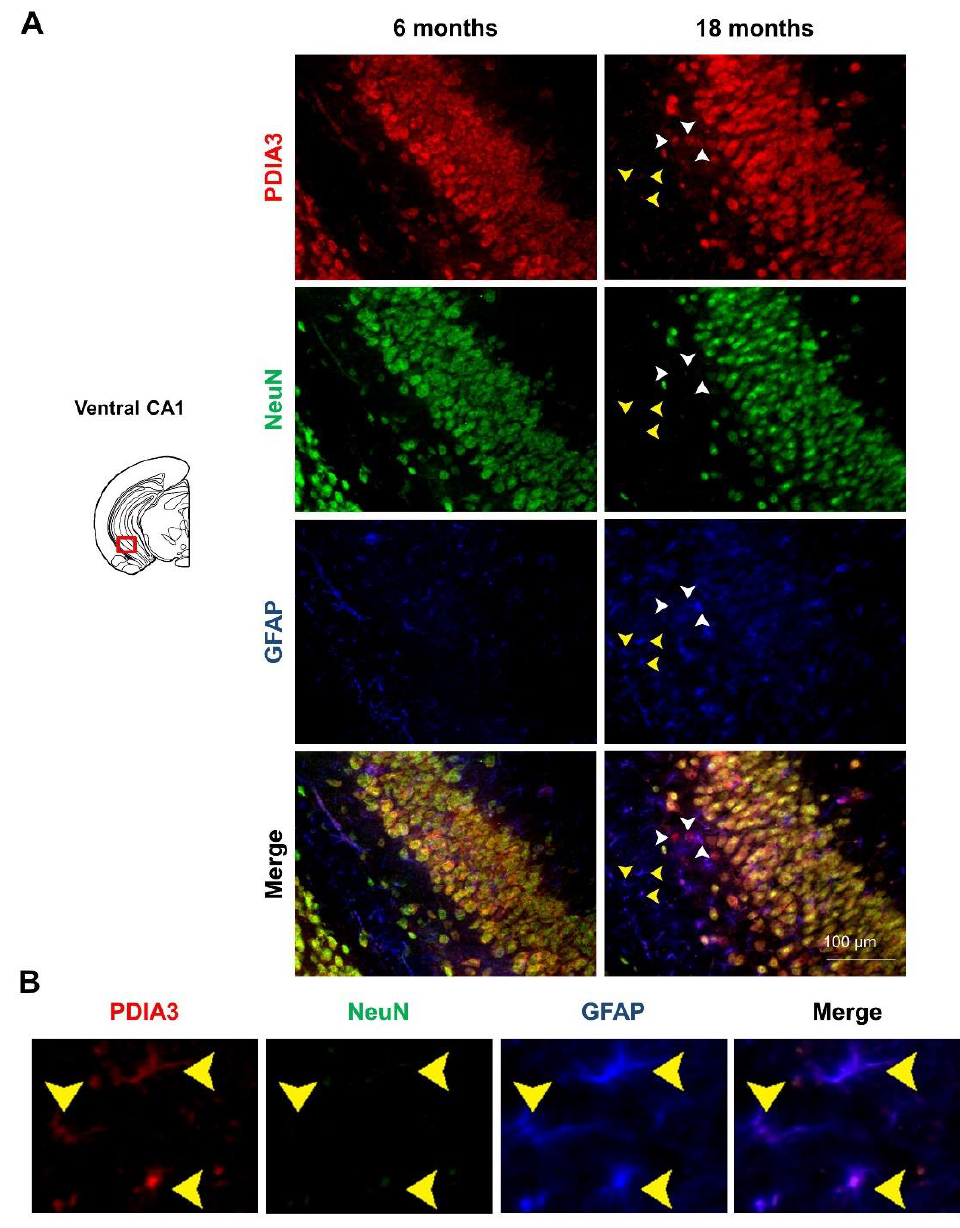
Figure 9. PDIA3-NeuN-GFAP protein levels observed in the ventral CA1 region of the hippocampus of 3 × Tg-AD mice: ( A ) Representative microphotographs of PDIA3-NeuN-GFAP triple-fluorescent immunostaining (red, green, and blue, respectively) performed on brain slices of ventral CA1 region of hippocampus collected from 6- and 18-month-old 3 × Tg-AD mice. The white arrows indicate the PDIA3 single-positive cells while the yellow arrows indicate the PDIA3-GFAP co-localization. Original magnification: 20 × ; scale bar was set at 100 µ m; ( B ) Representative microphotographs of PDIA3-GFAP co-localization in astrocytes from ventral CA1 region of hippocampus of 18-month-old 3 × Tg-AD mice.